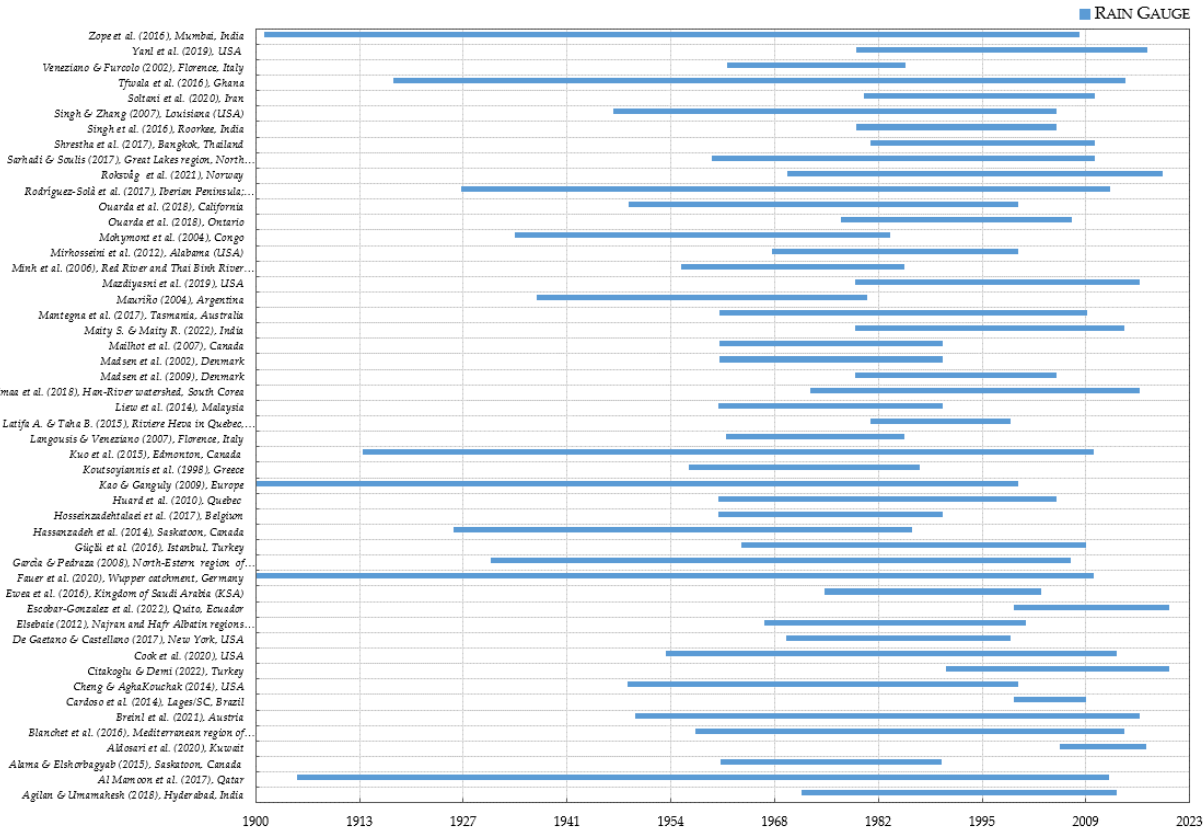
Figure 3. Years of coverage for each rain-gauge dataset [45 – 90].